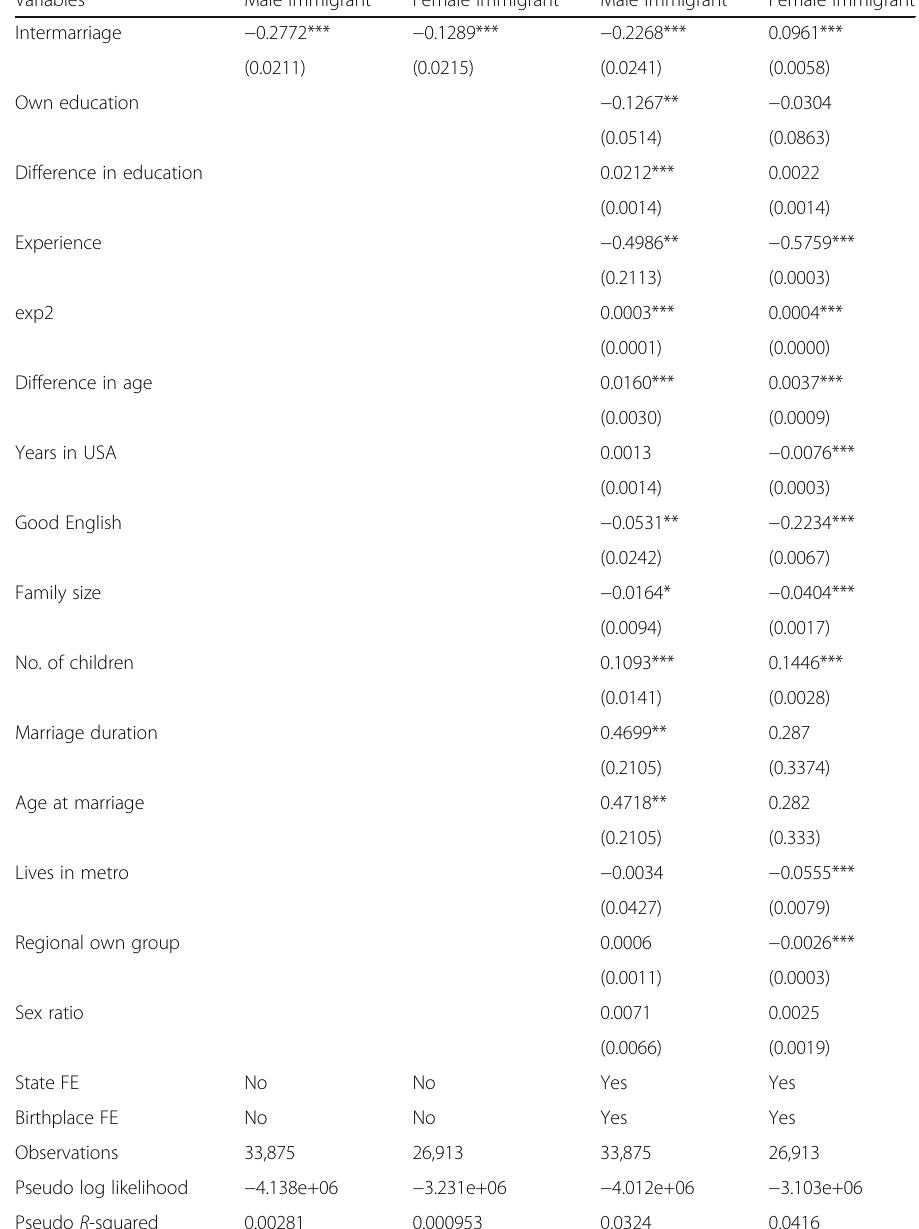
Table 6 Two-limit Tobit estimates for the impact of intermarriage on household specialization: subsample of households with “ traditional ” gender roles Variables Male immigrant Female immigrant Male immigrant Female immigrant Intermarriage −